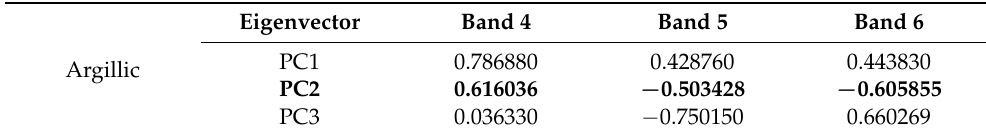
Table 3. Eigenvector matrix of the argillic minerals calculated using the SPCA method for ASTER bands 4, 5, and